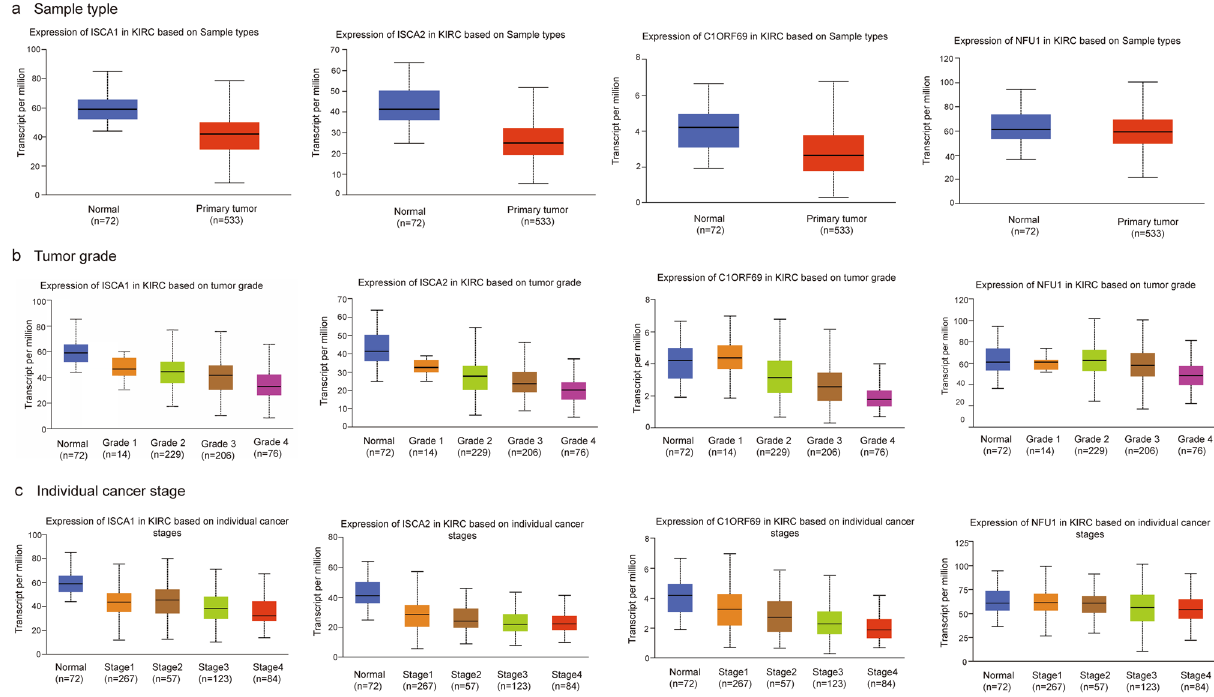
Figure 3. The mRNA expression levels of the MMDS related iron–sulfur protein genes in KIRC of different pathological stages. ( a ) Between tumor and normal tissues. ( b ) Among different tumor grades. ( c ) Among different individual cancer